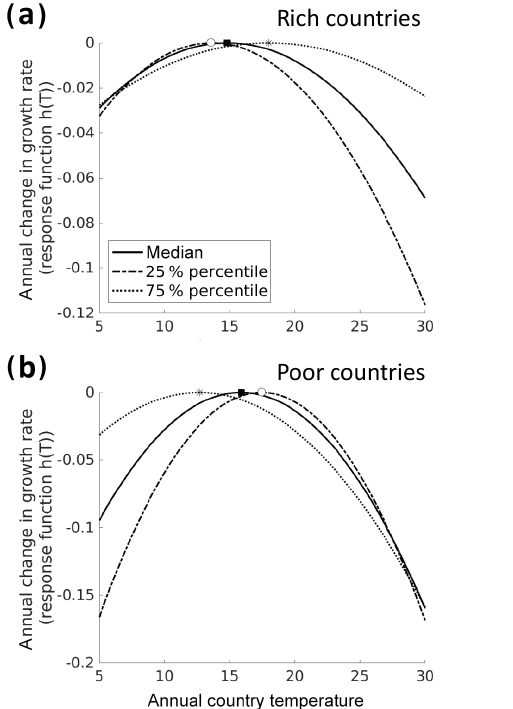
Figure A4. Effect of annual average country temperature on eco- nomic production (median, 25th, 75th percentiles) for (a) rich and (b) poor countries based on regression parameters (median specifi- cation and standard errors) of the base case in Burke et al. (2015; see also Eqs.